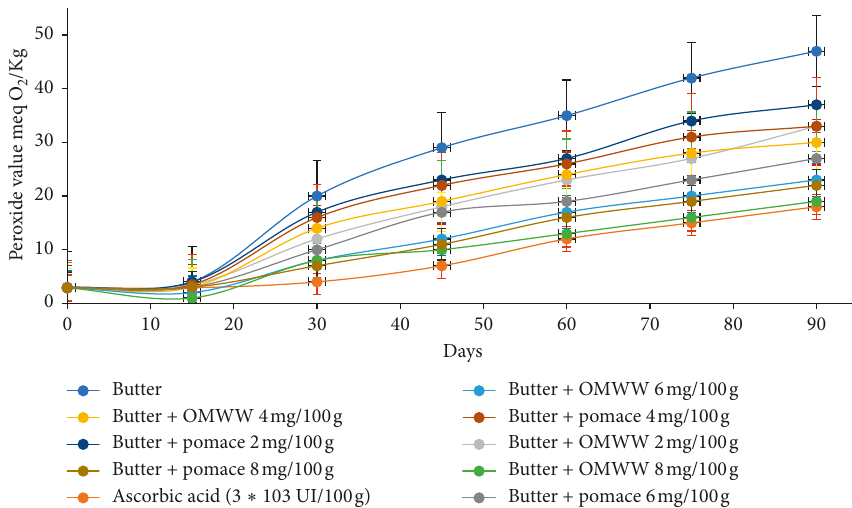
Figure 6: Evolution of the peroxide value as a function of the storage time of butter at 25 ° C. Table 3: Butter peroxide value at 90 days storage at 25 ° C.